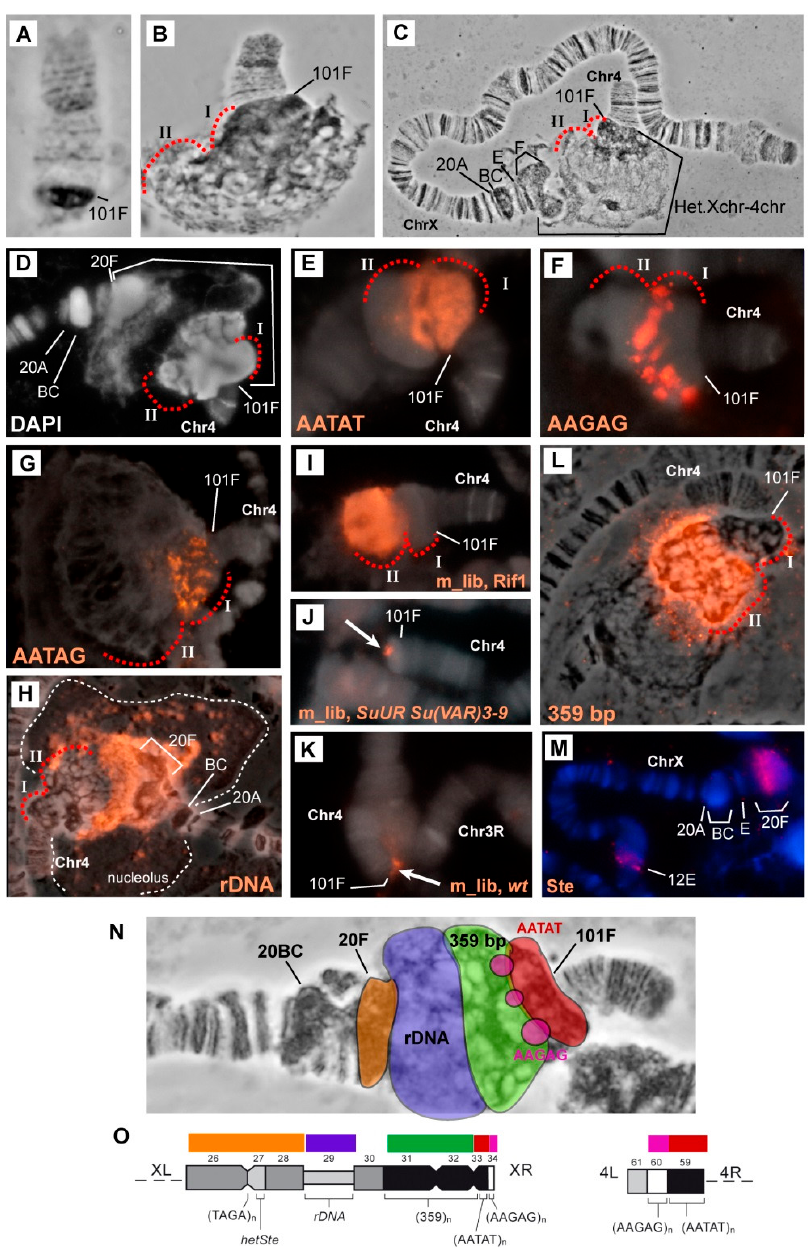
Figure 2. Mutations in the Rif1 gene lead to the polytenization of satellite sequences from the proximal heterochromatin of chromosomes X and 4 as well as rRNA genes. ( A – D ) Morphology of the pericentromeric region of chromosome 4 in the control line SuUR ES Su(var)3-9 06 ( A ) and in the Rif1 mutants ( B – D ). Red dotted arcs distinguish two zones of different morphology at the base of chromosome 4, indicated by Roman numerals I and II. A merger of the pericentromeric regions of chromosomes X and 4 is indicated by brackets ( C,D ). Aceto-orcein staining, phase contrast microscopy ( A – C ) and DAPI staining ( D ). ( E – M ) In situ hybridization of DNA probes corresponding to heterochromatin sequences from chromosomes X and 4 onto polytene chromosomes of Rif1 1 /Rif1 2 ( E – I,L , M ), SuUR ES Su(var)3-9 06 ( J ) and wild-type larvae. The probes are indicated in figure; m-lib: microdissection library, the white or blue color: DAPI staining and the red color: a hybridization signal. In all figures, Chr4 denotes chromosome 4, ChrX denotes chromosome X, two zones at the base of chromosome 4 (I and II) are marked with dotted arcs in accordance with panel B. The white outline in H indicates the nucleolus. ( N , O ) generalized scheme of localization of all the probes used in relation to the structures of polytene chromosomes X and 4